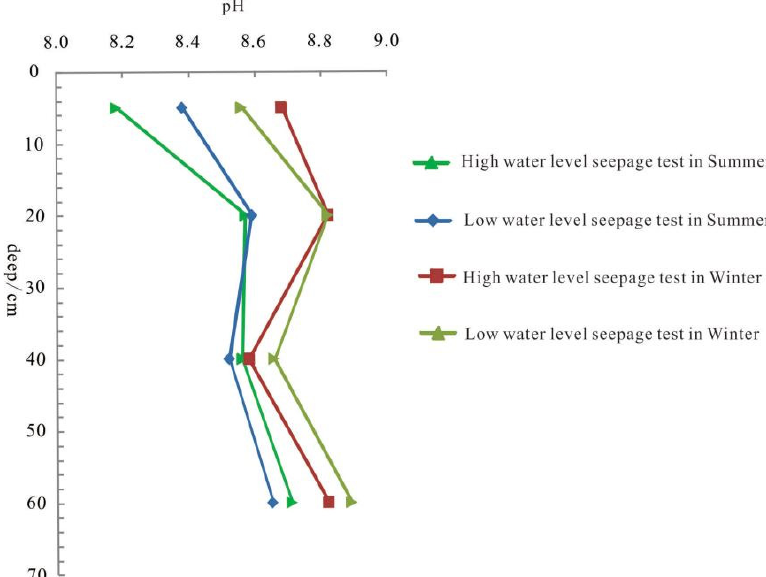
Figure 4. Characteristics of pH transport in the subsurface under different hydrodynamic excitation conditions in wet and dry periods.